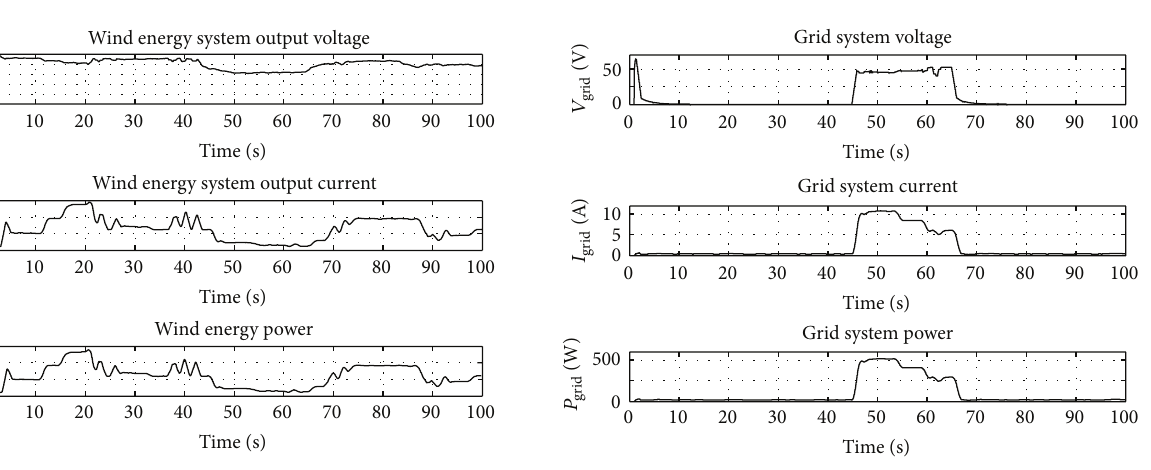
Figure 20: Current, voltage, and power change in WES for case 2.